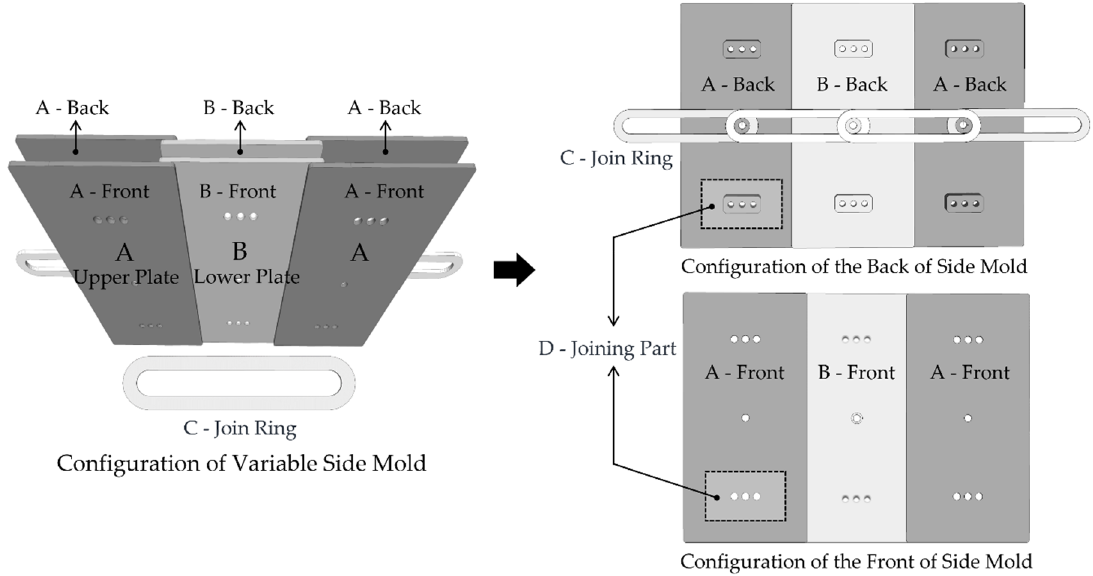
Figure 4. Variable side mold length adjustment method. (A: Upper Plate, B: Lower Plate, C: Join Ring, D: Joining Part).